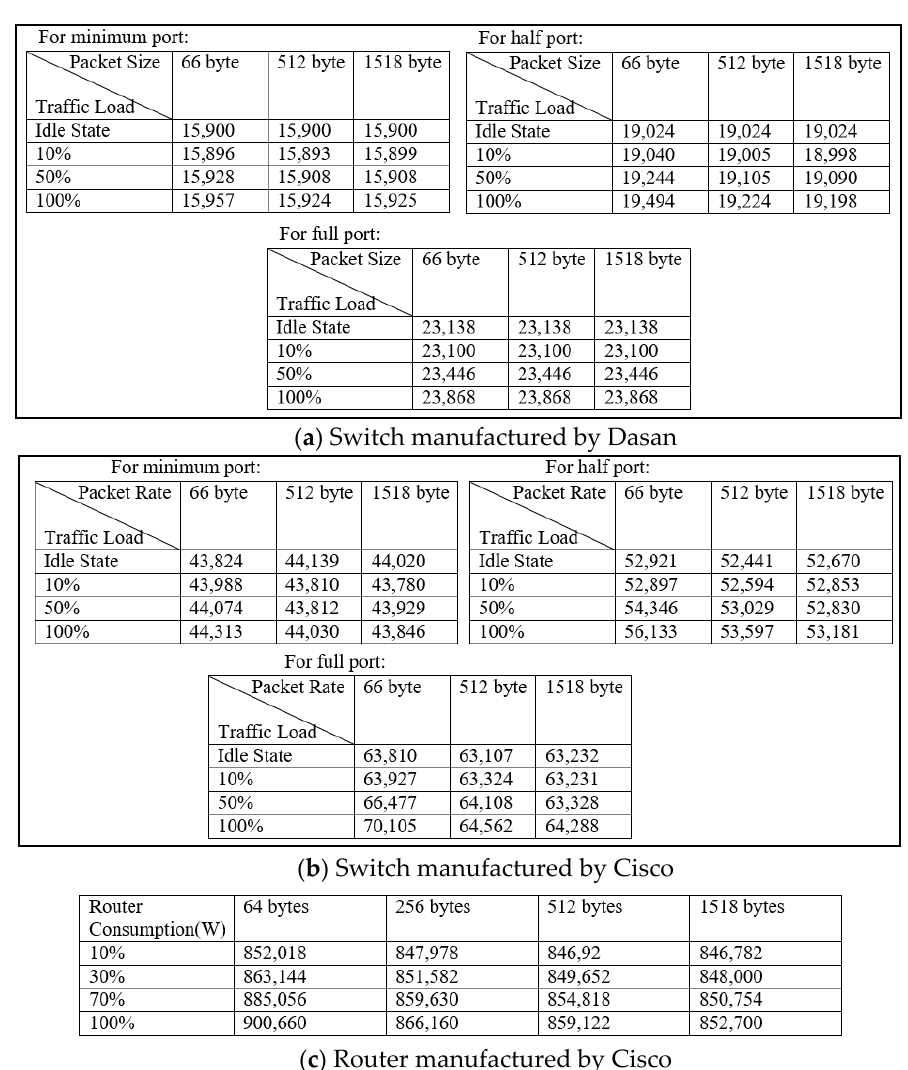
Figure 11. Power consumption results of network devices. ( a ) Switch of DASAN; ( b ) Switch of Cisco; ( c ) Router of Cisco.